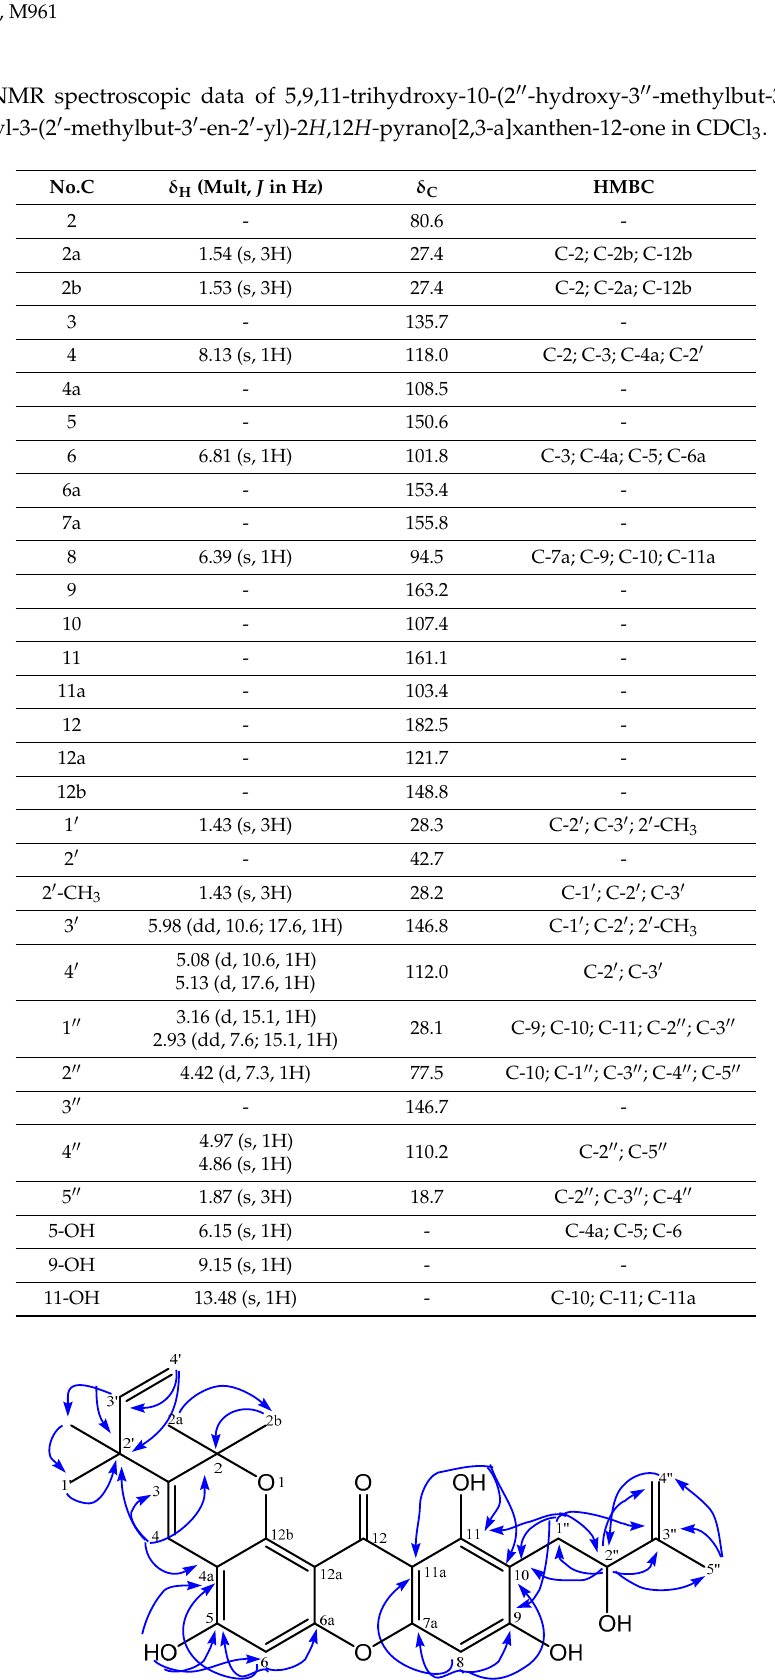
Table 1. NMR spectroscopic data of 5,9,11-trihydroxy-10-(2 (cid:48)(cid:48) -hydroxy-3 (cid:48)(cid:48) -methylbut-3 (cid:48)(cid:48) -en-1-yl)- 2,2-dimethyl-3-(2 (cid:48) -methylbut-3 (cid:48) -en-2 (cid:48) -yl)-2 H ,12 H- pyrano[2,3-a]xanthen-12-one in CDCl 3 .